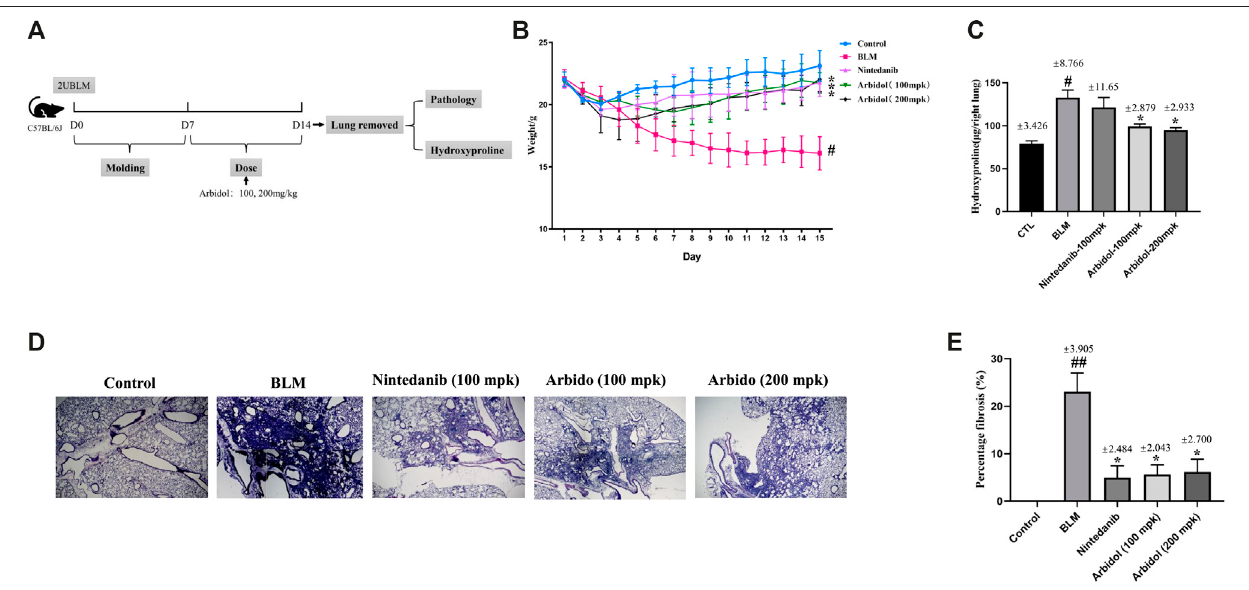
FIGURE 1 | Effect of arbidol on BLM-induced pulmonary fi brosis in mice. (A) Experimental protocol of BLM-induced IPF in mice. (B) Arbidol signi fi cantly inhibited BLM-inducedweightlossinmice. (C) Arbidolsigni fi cantlyinhibitedthelevelsofhydroxyprolineinthelungtissueofmice (D) HEstainingwasusedtoevaluatetheeffectof arbidol on BLM-induced pathological changes (20 × magni fi cation). (E) Percentage of fi brosis was quanti fi ed by Ashcroft score system. Values are presented as the mean ± SEM (n (cid:1) 5), # p < 0.05, signi fi cantly different from control group; * p < 0.05 signi fi cantly different from model